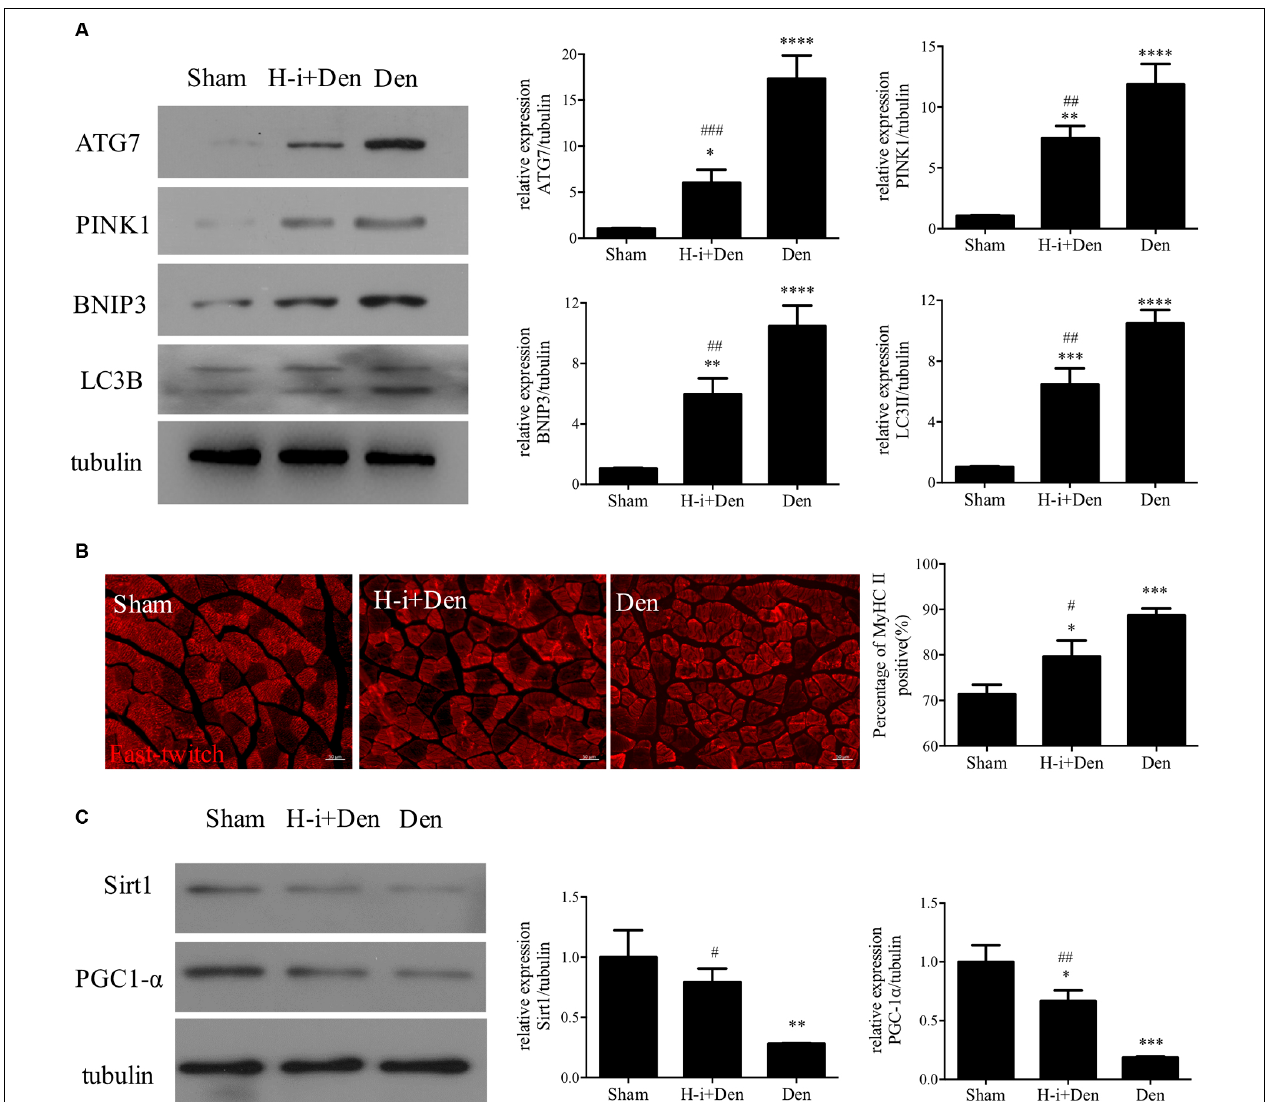
FIGURE 2 | HDAC4 inhibition reduced the expression of autophagy-related proteins and retarded muscle fiber type transformation in denervated skeletal muscle. (A) The expression of autophagy-related proteins in tibialis anterior muscle was detected by Western blot. The sciatic nerve transection model was prepared after injection of HDAC4-shRNA lentivirus (H-i+Den) or empty vector virus (Den) into the tibialis anterior muscle of mice. The empty vector virus was injected into muscles from the sham group (Sham). After 14 days, the expression of autophagy-related proteins in tibialis anterior muscle was detected by Western blot. (B) MyHC II fiber staining was used to analyze the fast muscle fibers in the tibialis anterior muscle after denervation and the positive rate of MyHC II fiber was calculated. (C) The expression changes of mitochondrial generation associated proteins (SIRT1 and PGC-1 α ) in tibialis anterior muscle were detected by Western Blot after denervation. ∗ P < 0.05, ∗∗ P < 0.01, ∗∗∗ P < 0.001, ∗∗∗∗ P < 0.0001 vs. sham group. # P < 0.05, ## P < 0.01, ### P < 0.001 vs. denervated